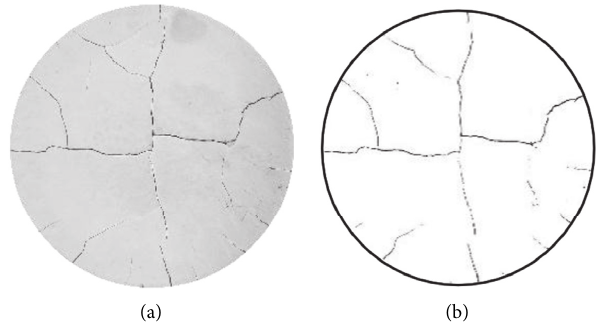
Figure 3: Raw and binary images.